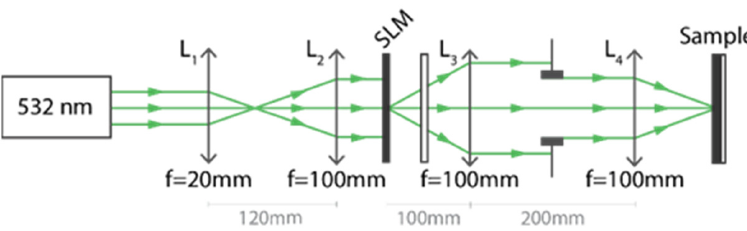
Figure 2. Optical setup for the direct writing of CGHs through photodissolution. The 532 nm con ‐ tinuous ‐ wave laser is expanded with 5× magnification using two achromatic lenses, L1 and L2, and shines a spatial light modulator (SLM). L3 and L4 are two additional achromatic lenses that image the SLM on the sample plane with a 1×